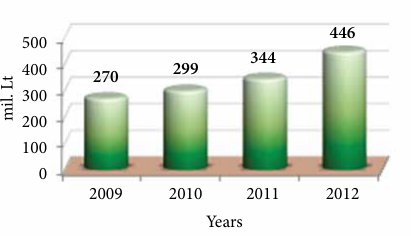
Fig. 2. The payments of the AB ‘Lietuvos geležinkeliai’ to the budgets of the state, municipality and ‘Sodra’ (State Social Insurance Fund Board under the Ministry of Social Security and Labour) and other financial contributions to the state economy in 2009–2012 (million